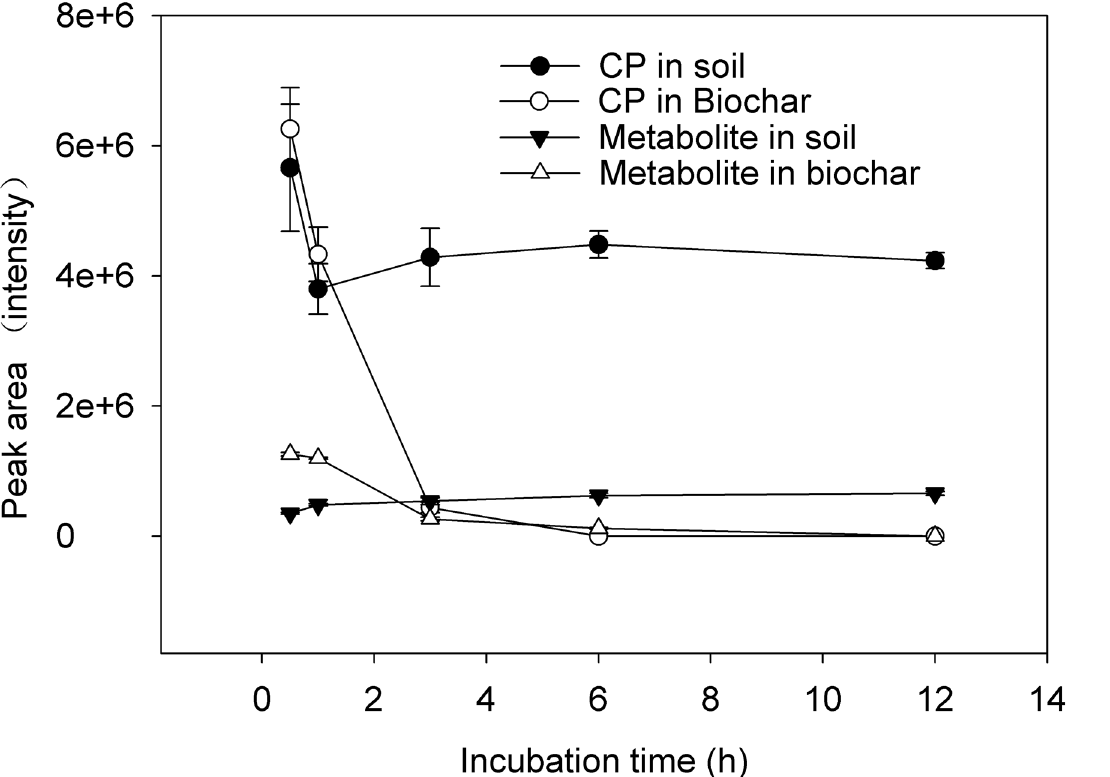
Fig 6. Changes in concentration of CP and dichloronitromethane in soil and in